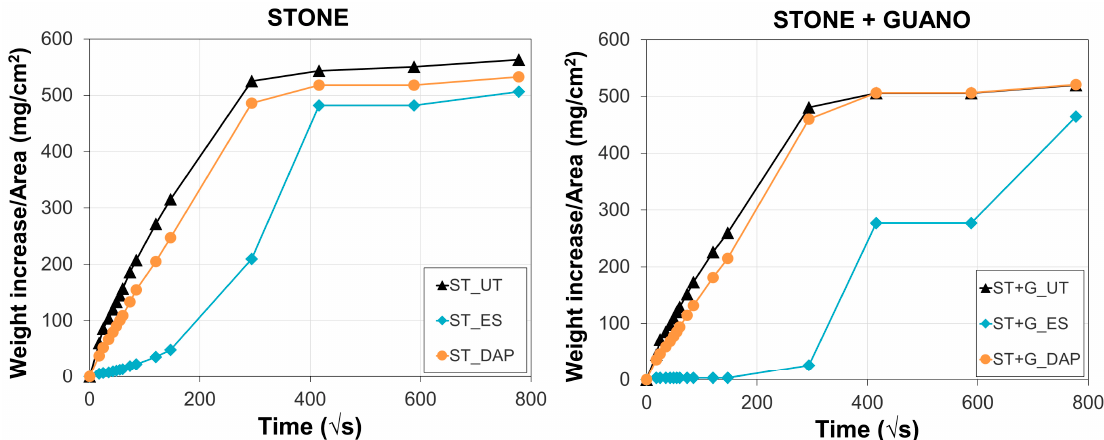
Figure 13. Water absorption as a function of time of untreated (“UT”) and treated (“ES” and “DAP”) stone (“ST”) and stone+guano (“ST+G”) specimens. Table 2. Water transport properties of untreated and treated